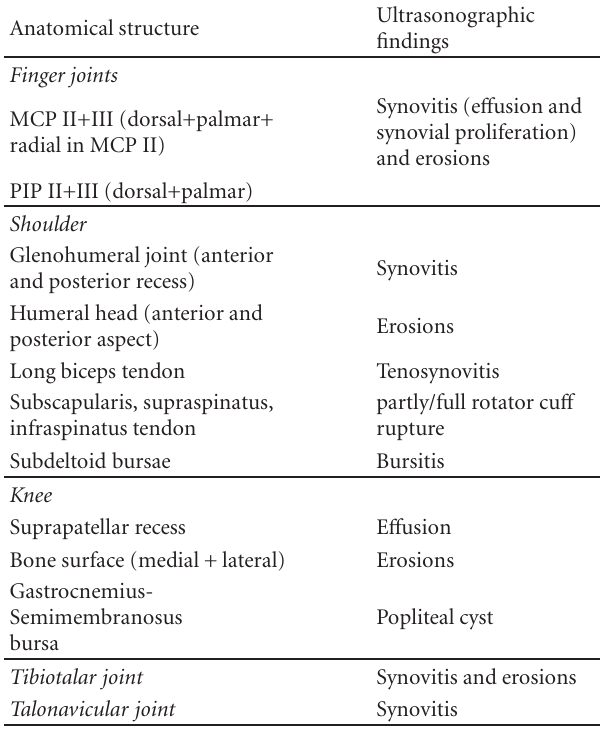
Table 1: Ultrasonographic